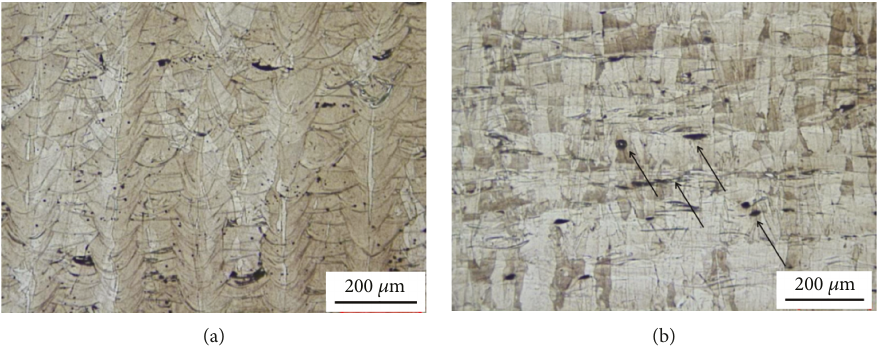
Figure 17: (a) Optical micrographs of the Y-Z plane and (b) of the X-Z plane of sample 1.